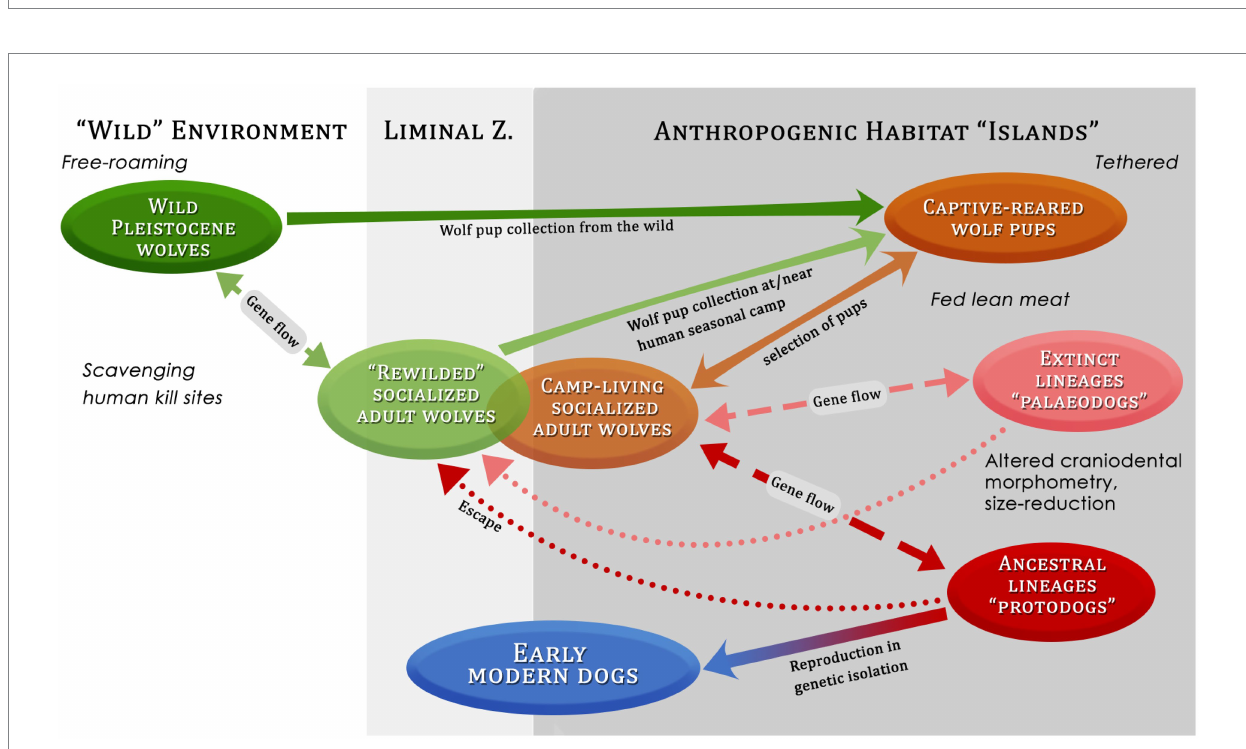
FIGURE 8 Possible pathways in the domestication process of dogs from wolves, showing several factors such as environment, selection, protection, food and provisioning. Liminal Z = Liminal